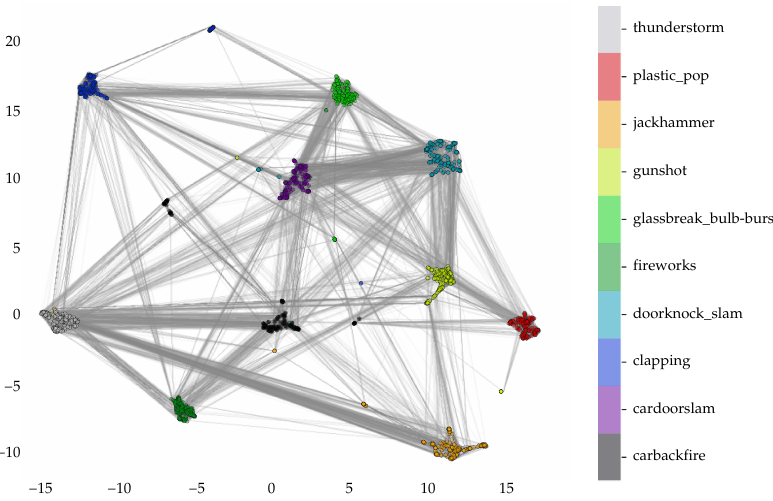
Figure 12. UMAP connectivity for the gunshot and gunshot-like